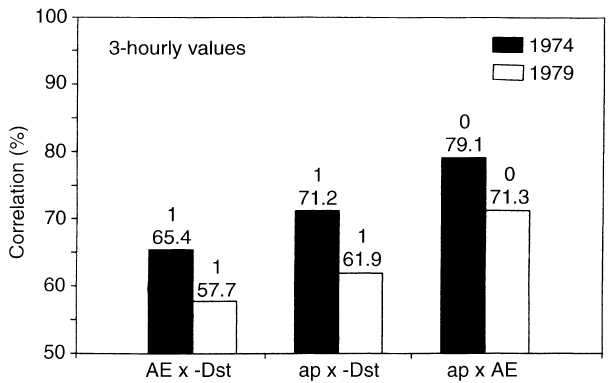
Fig. 5. Monthly average values of Dst and the monthly correlations of ap (cid:180) ) Dst for 1974